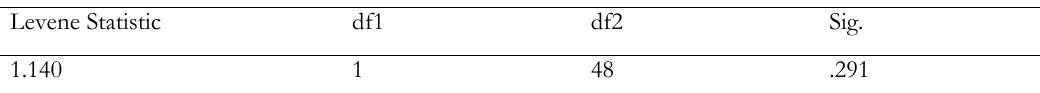
TABLE 4. Test of Homogeneity of Variances Post-test Score